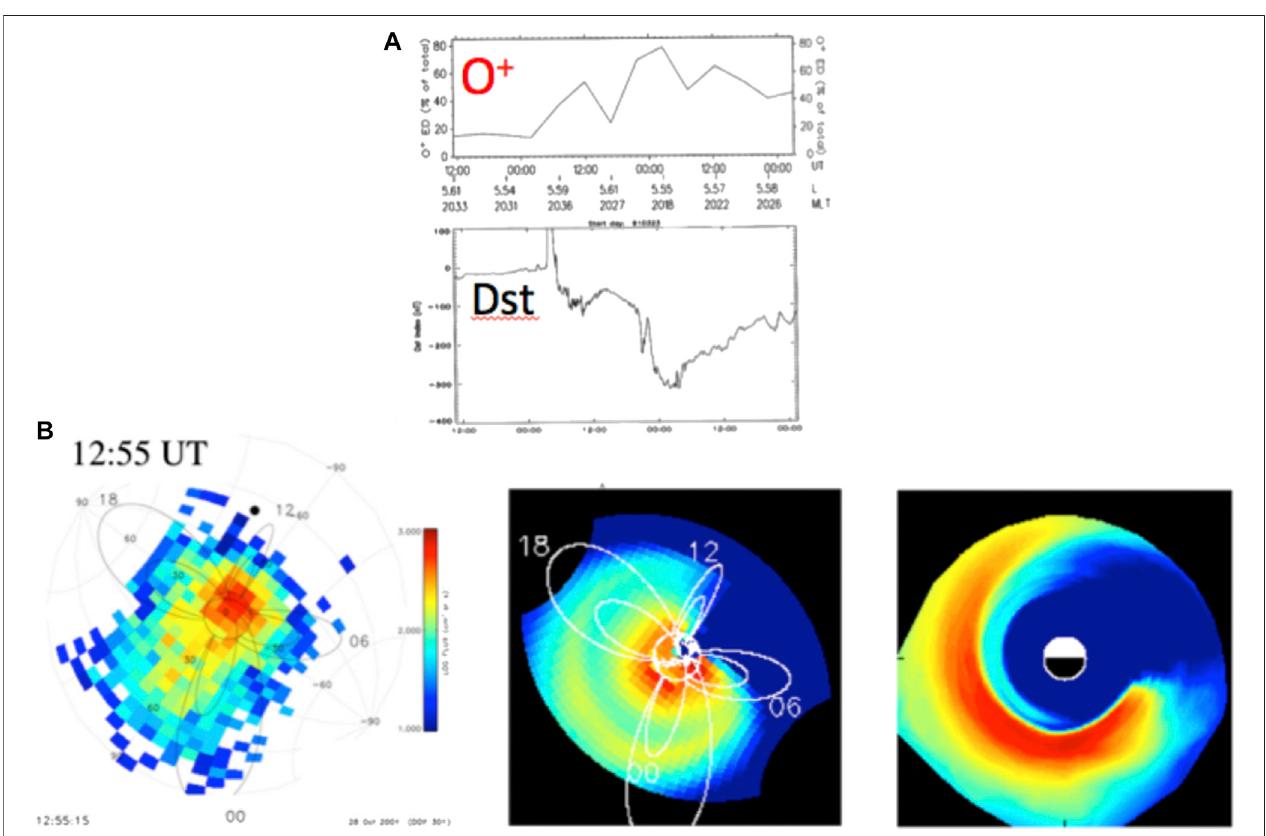
FIGURE 18 | (A) The relationship between the intensity of oxygen ions and the Dst index (Daglis, 1997). (B) Imaging the ring current and a simulation study. From the left, an actual image, its relation to the earth ’ s dipole fi eld and a simulation study of the movement of oxygen ions (Fok, 2003).